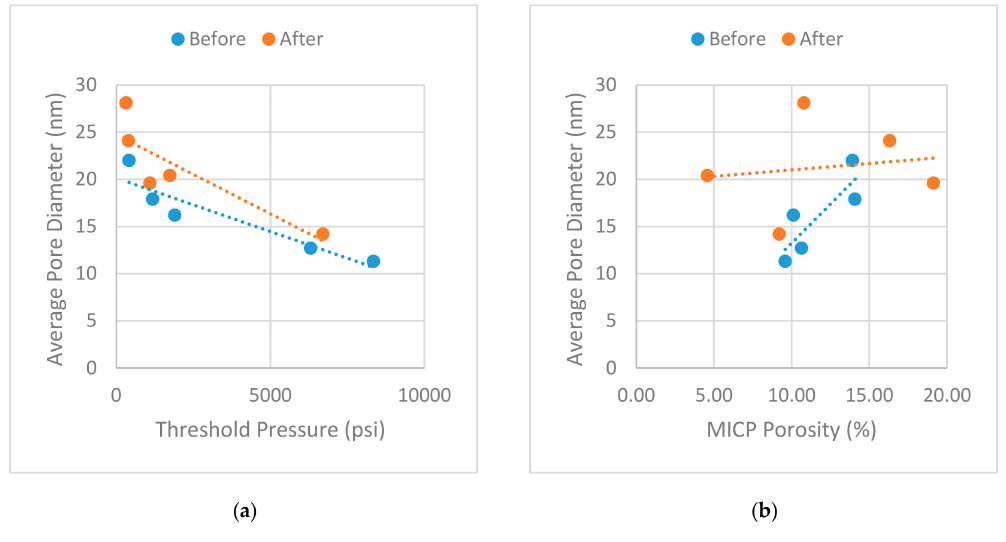
Figure 15. Pore throat diameter versus ( a ) threshold pressure and ( b ) MICP